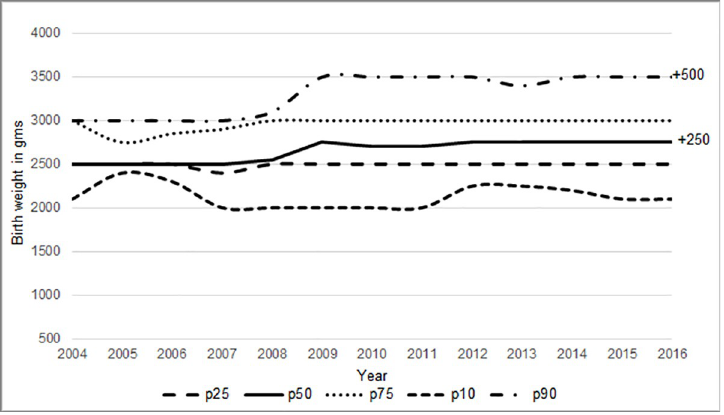
Fig 2. Trends in different quartiles of birth weights. p10-10 th percentile, p25-25 th percentile, p50-median, p75- 75 th percentile, p90-90 th percentile.